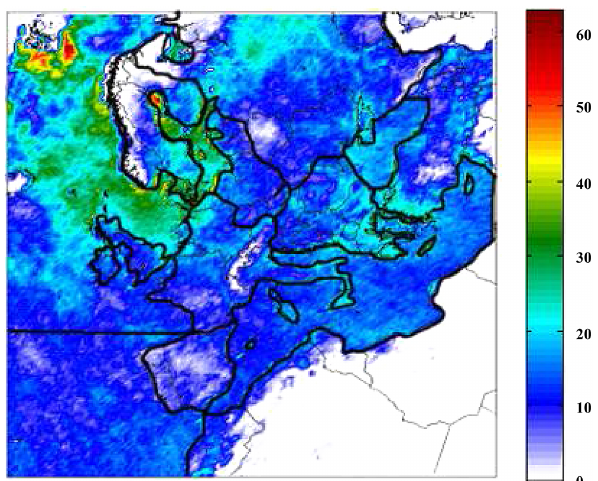
Figure 2. Geographical distribution of the number of available AOD retrievals from MODIS over Europe during May 2008. White color denotes no retrievals. Land is partitioned into eight regions including the United Kingdom and Ireland, central Europe, north- ern Europe, Spain and Portugal, eastern Europe, Balkans, Rus- sia/Belarus/Ukraine, Turkey, and northern Africa. The sea is par- titioned into four regions: the Mediterranean, North Atlantic, South Atlantic, and Black Sea.